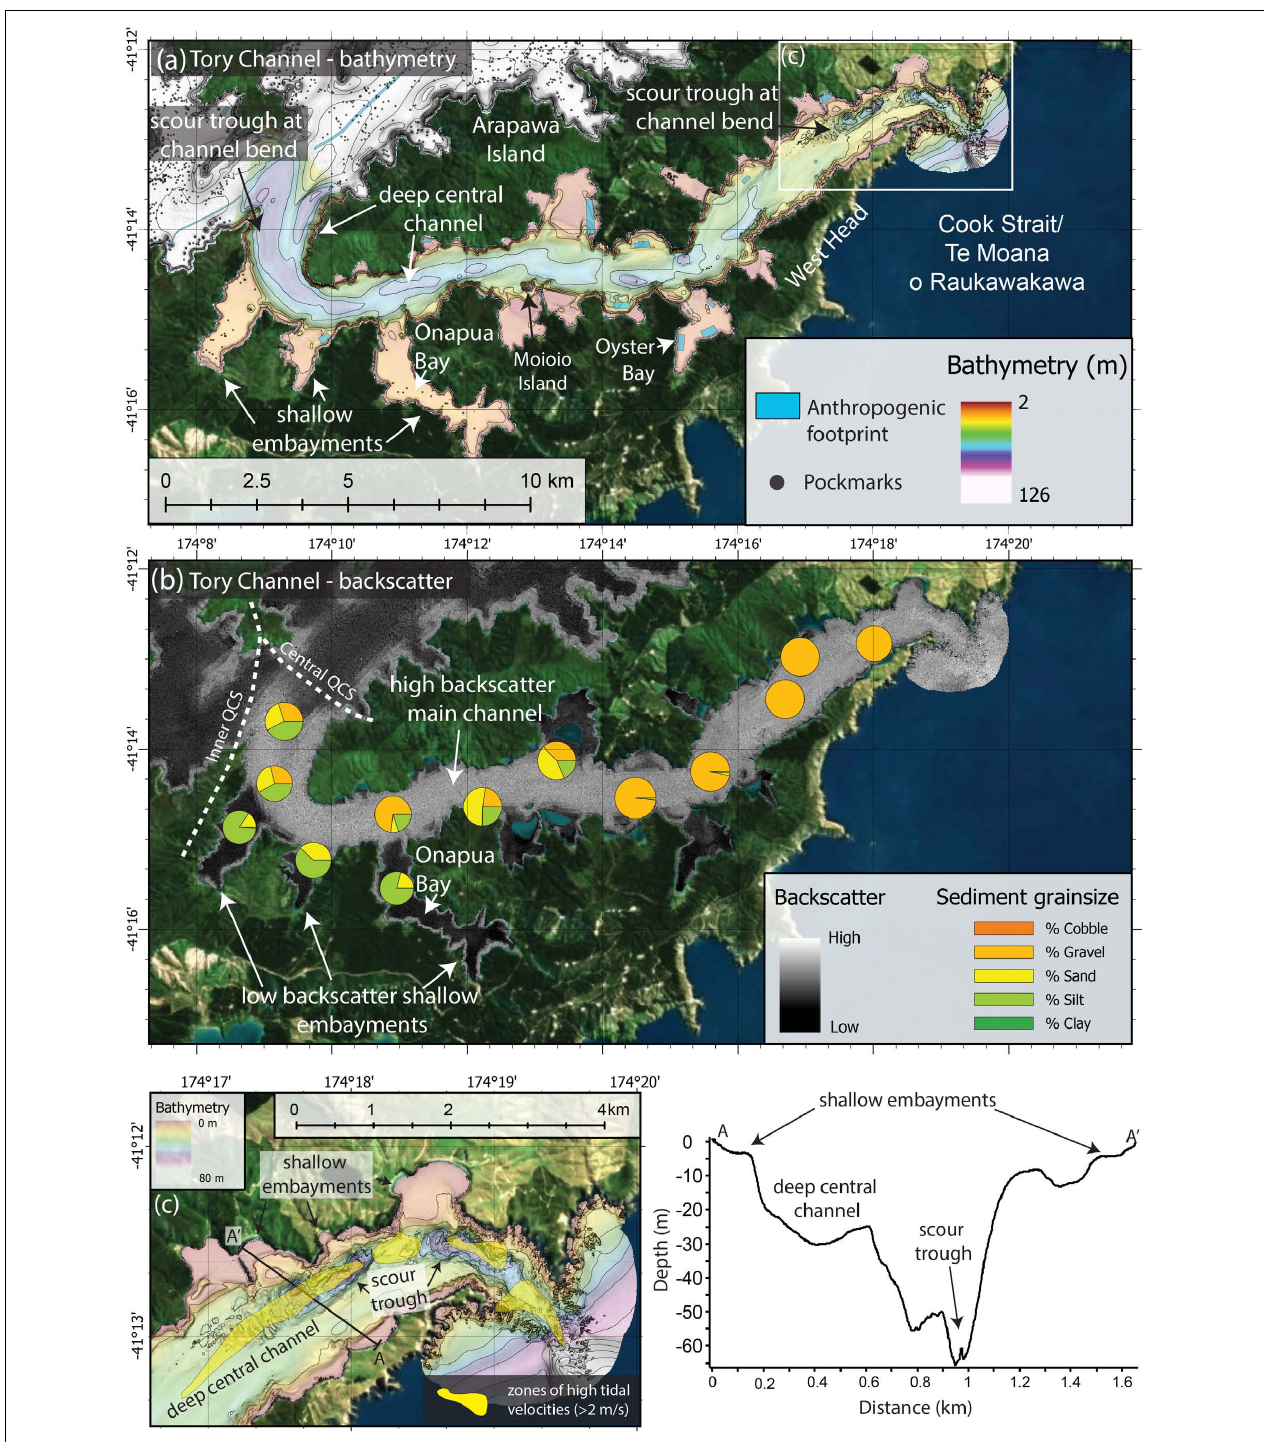
FIGURE 10 | (a) Gridded 2-m bathymetry overview of the TC. For location of TC see Figure 1b . Features described in the main text are labeled. Blue transparent polygons are regions affected by anthropogenic activities, black points are locations of pockmarks, black lines are bathymetric contours at 10 m intervals. Black rectangle shows location of inset c. (b) 0.5 m seafloor backscatter mosaic in the TC. For clarity, pie charts show a subset of sample grain-size distributions that are representative of the trends observed in the complete dataset (for locations and grainsize distribution data for all samples collected in the HS51 project, refer to Supplementary Material 1 ). (c) detailed view of TC entrance to Cook Strait and the channel bend characterized by intense seafloor scouring that is spatially correlated zones of high tidal velocities ( > 2ms − 1 ; Plew and Stevens, 2013; Yellow polygons). Location of Profile A-A’ is shown, which highlights the distinctive difference in depth between the central channel and the TC